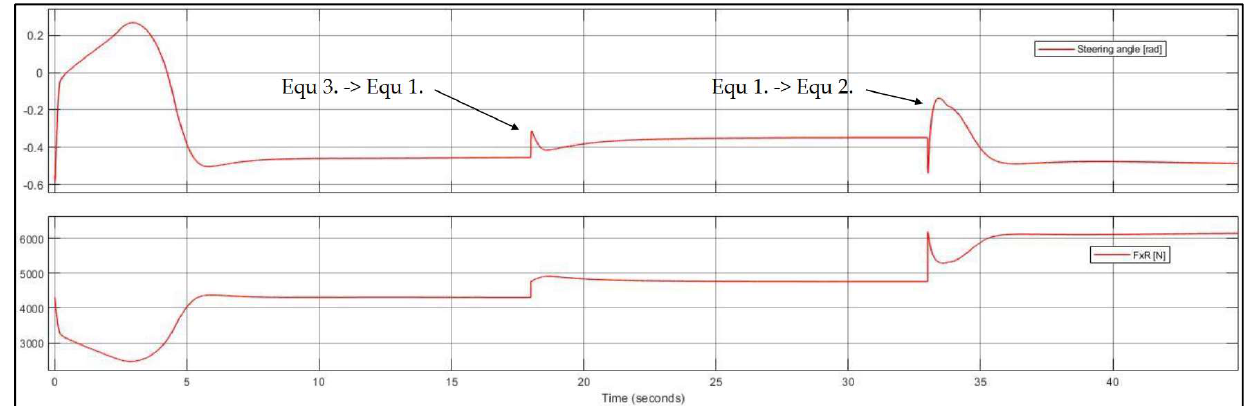
Figure 9. Evolution of states while settling in the three different equilibria.